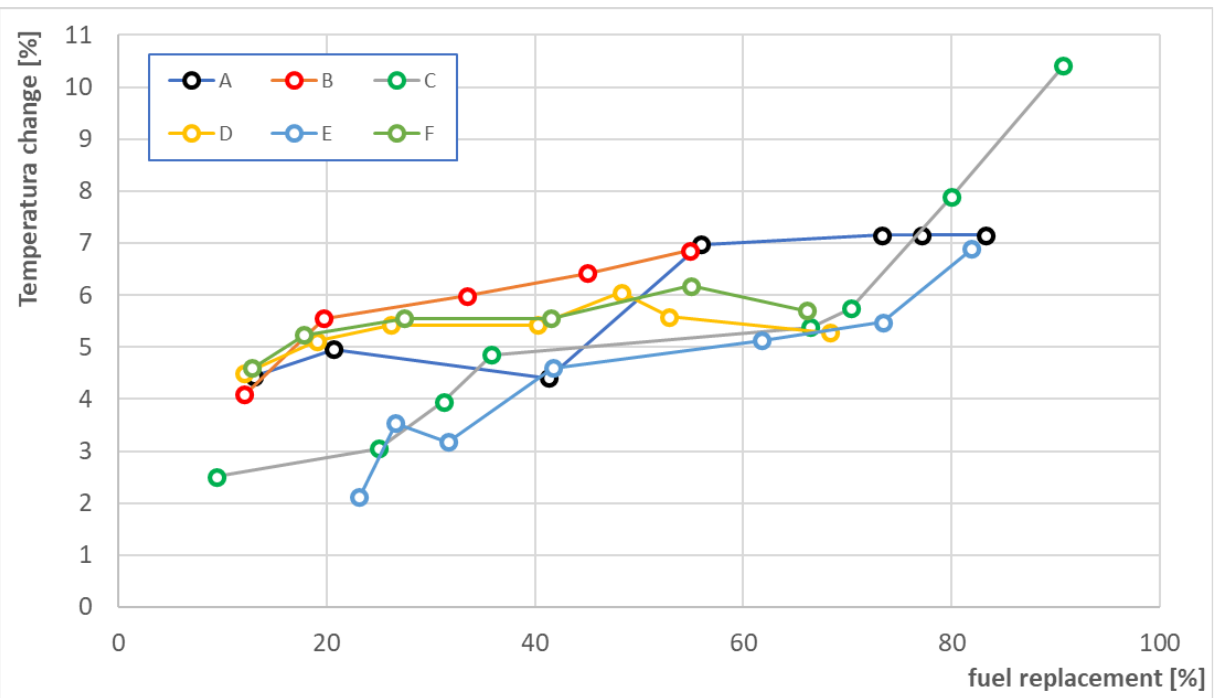
Figure 2. Curves from A to F showing the changes in the exhaust gas temperatures as the comparison of exhaust gas temperature noted only in single fuel (diesel) working mode for individual engine operating points, where the rotation speed, power, and torque were constant, as a dual-fuel mode (where engine uses CNG and diesel fuel) replacement function.